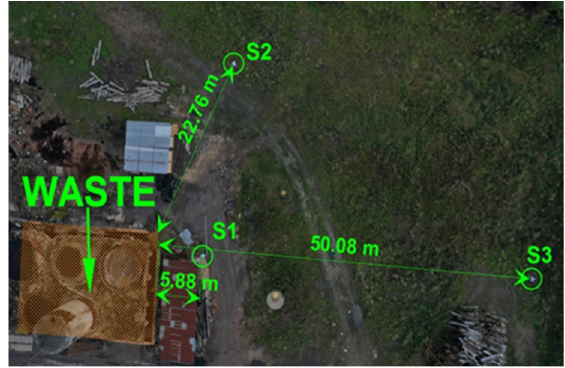
Table 1. Waste characteristics. pH 1 mol